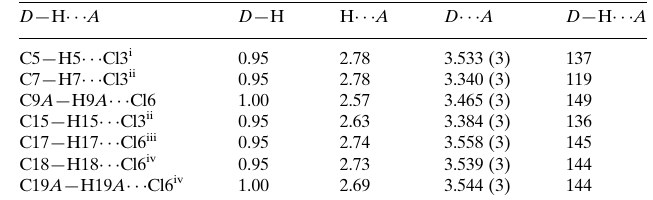
Hydrogen-bond geometry (A˚ , (cid:3)